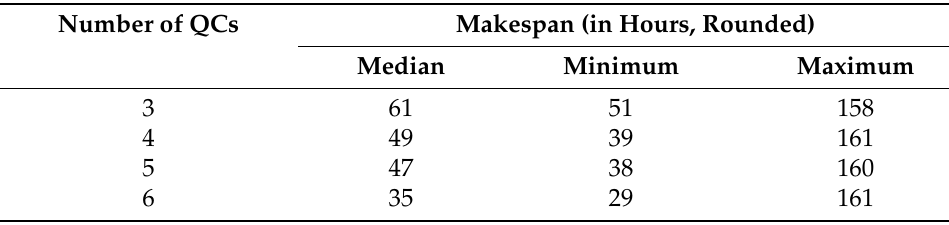
Table 1. Makespan of the ship for 100 randomly drawn experiments.